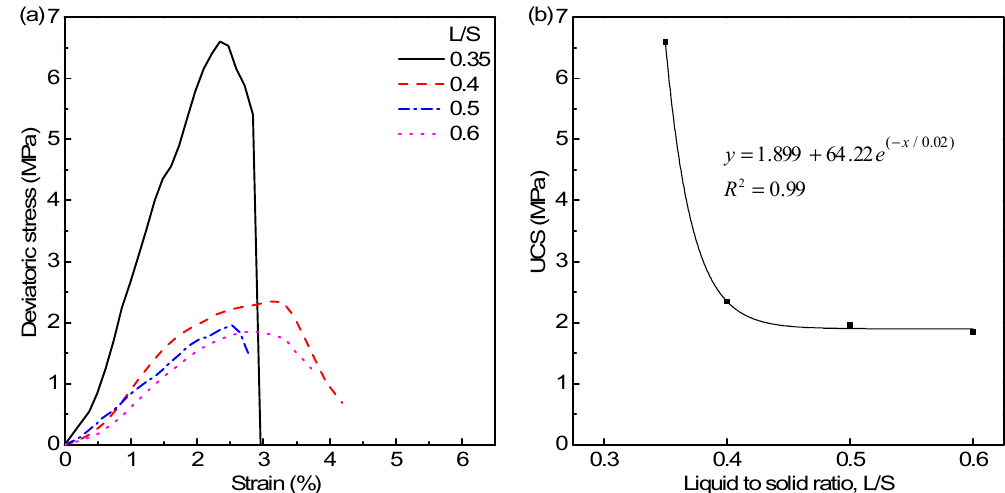
Figure 7. ( a ) Stress-strain curves of the end products at various liquid to solid (L/S) ratios; ( b ) the relationship between unconfined compressive strength (UCS) and L/S ratio after 7 days curing. The influence of L/S ratios on the UCS was studied using FA:RM ratio of 8:2 with L/S ranging from 0.35 to 0.6 w/w and the strength results are presented in Figure 7. The minimum L/S was chosen